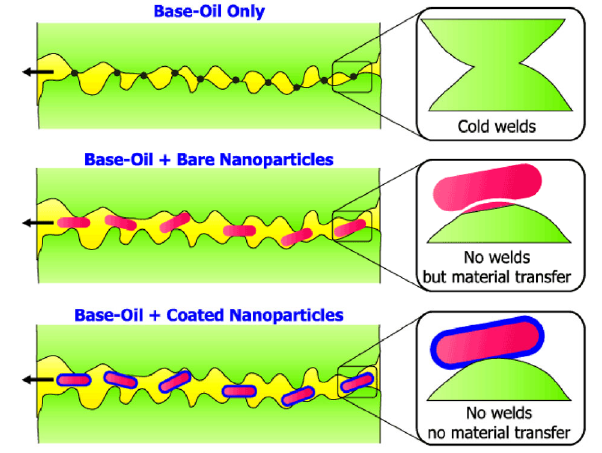
Fig. 17 Action mechanisms of nanoparticle additives